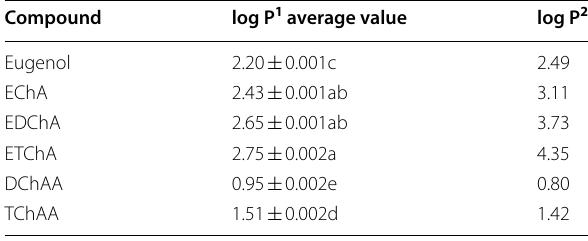
Table 1 Comparison of octanol/water partition coefficient values determined by the shake-flask method